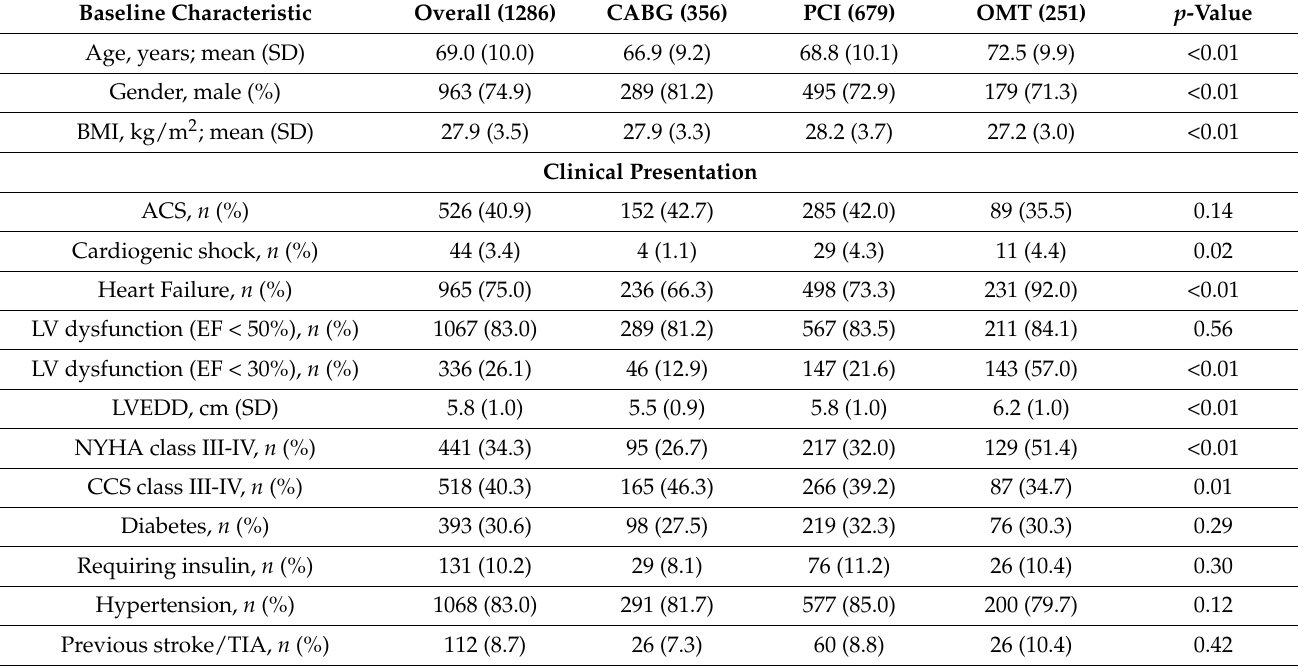
Table 1. Baseline clinical